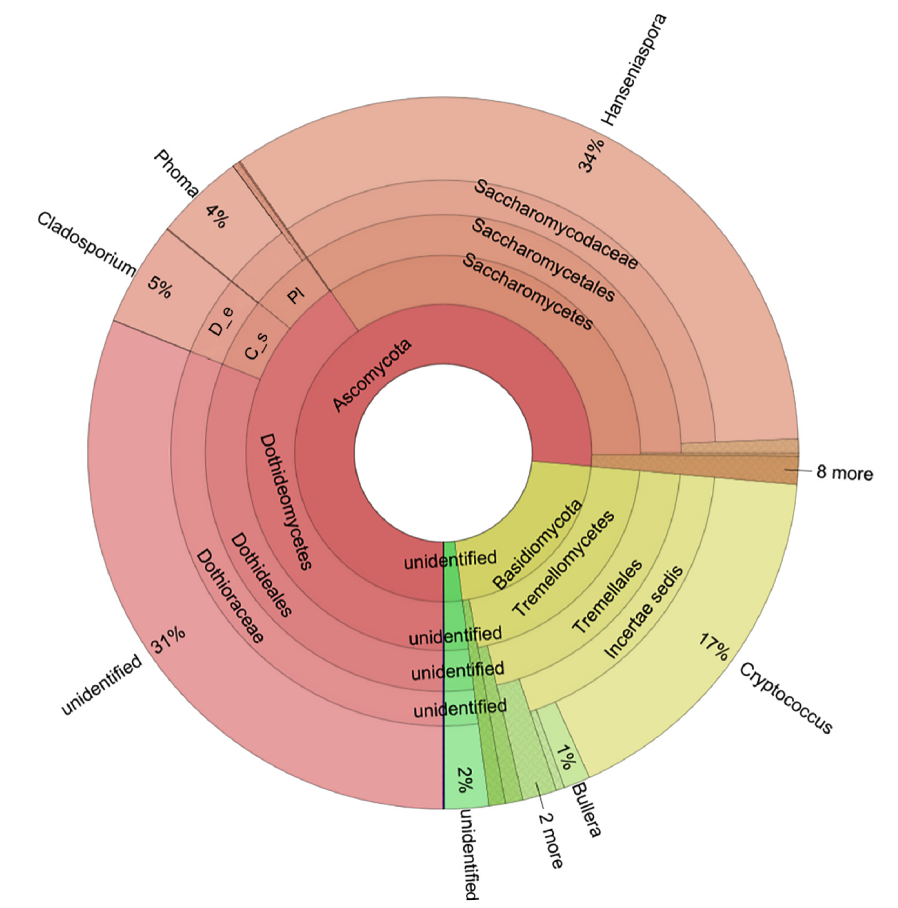
Figure 3. The taxonomic distribution of fungal microorganisms on M. alba carposphere. C_s – Capnodiales; D_e – Davidiellaceae; Pl – Pleosporales. Minor OTUs were not labeled. Pie-charts were constructed using KRONA (Ondov et al.,